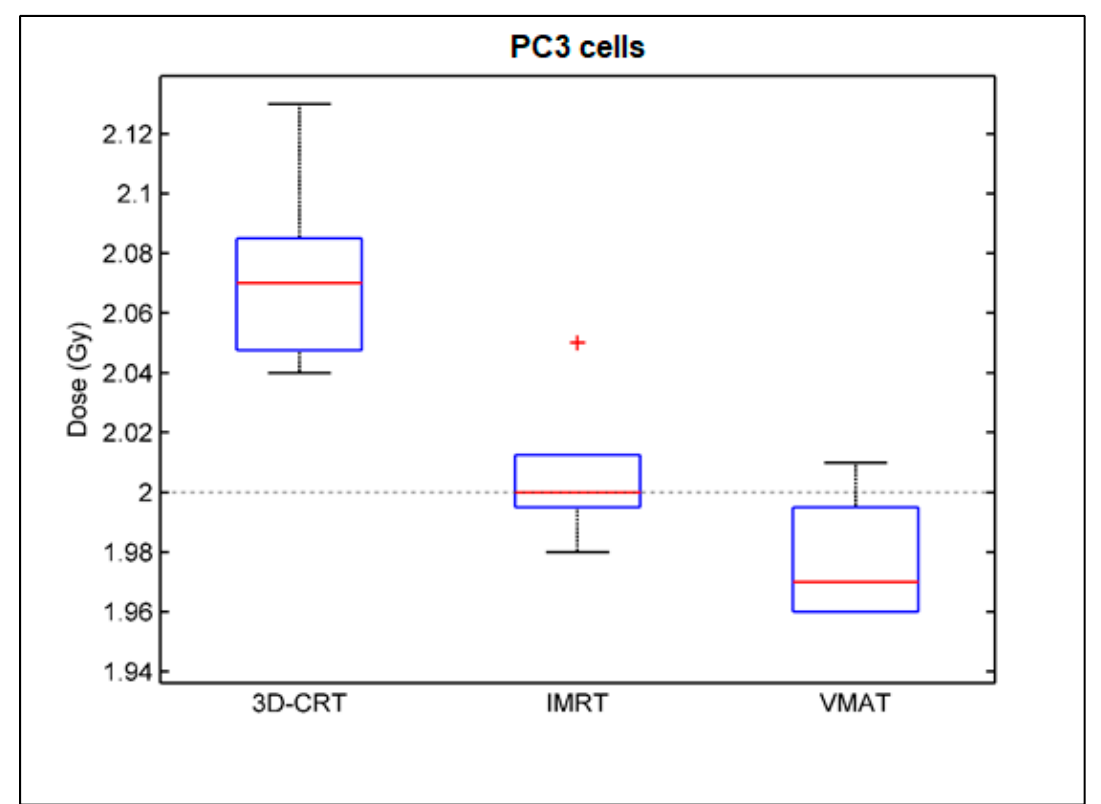
Figure 5. Box and whisker plots of the biological absorbed dose to the peripheral blood lymphocytes irradiated with the 3D-CRT, IMRT and VMAT technique across all prostate cancer patients.